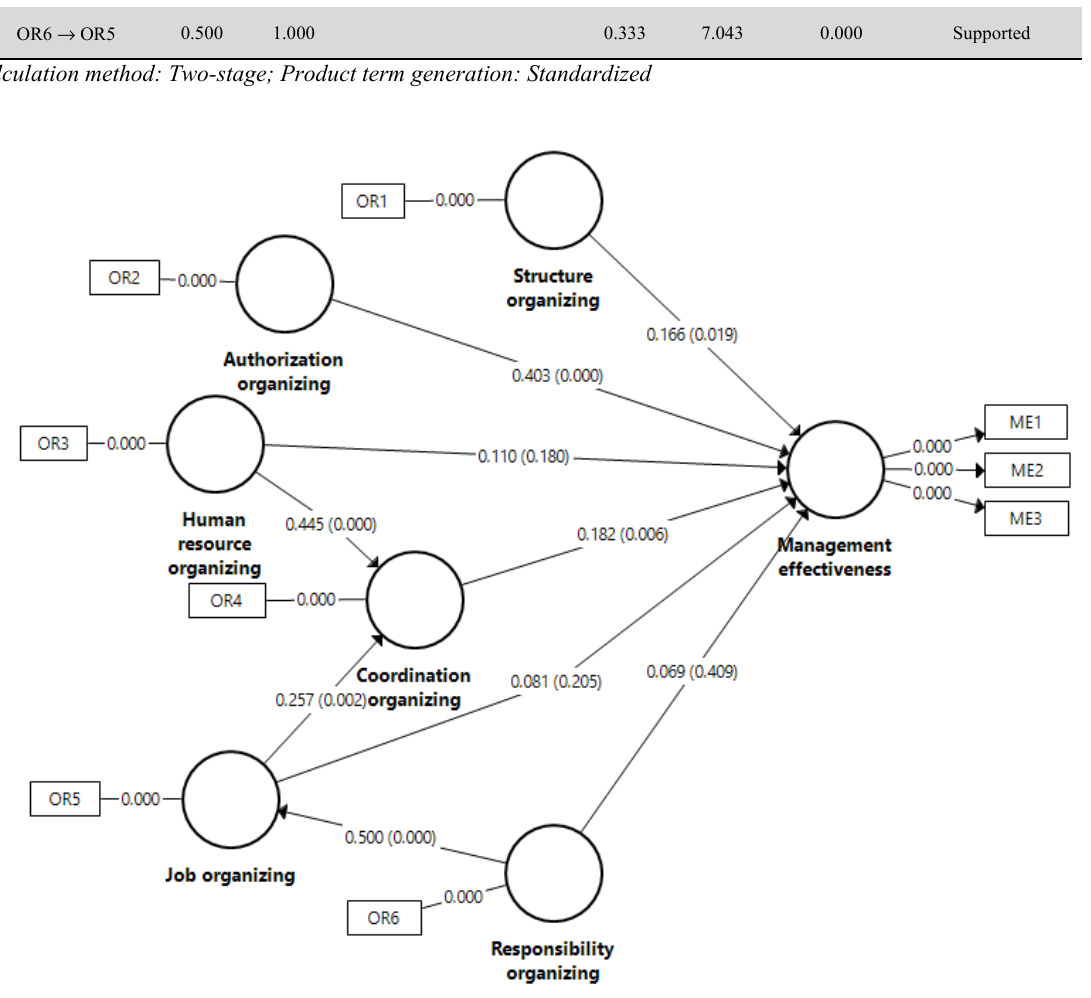
Fig. 1. Organizing behaviors and management